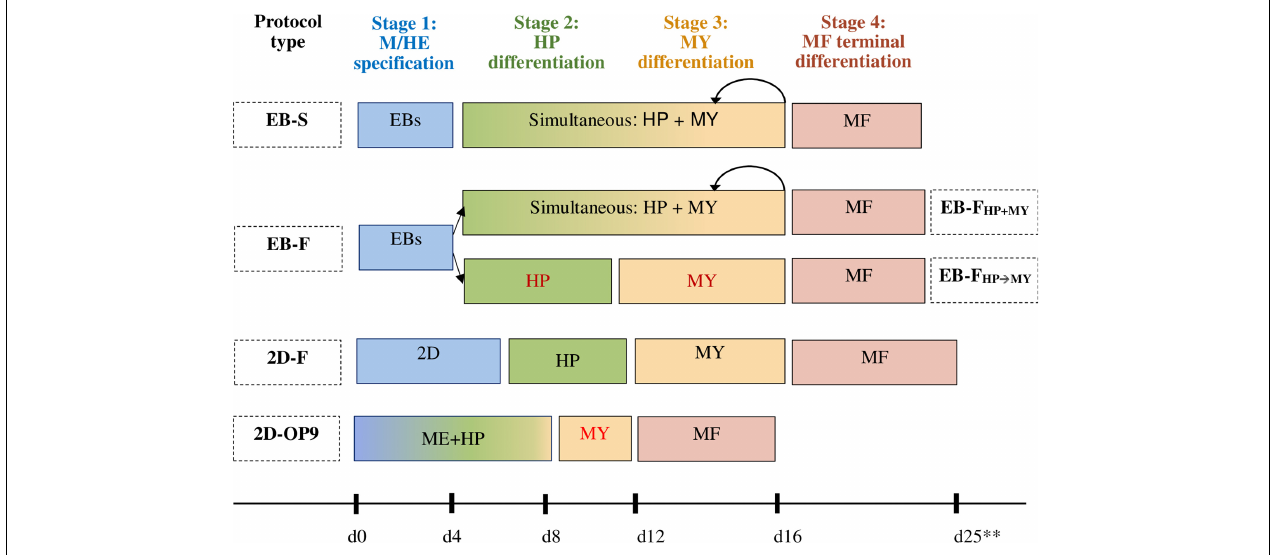
FIGURE 2 | Schematic representation of different protocols used to generate iMphs. In all protocols, the differentiation passes through four main stages: mesoderm commitment and hemogenic endothelium specification (M/HE stage, shown in blue); endothelial-to-hematopoietic transition and the generation of hematopoietic progenitors (HP stage, shown in green); myeloid specification and monocyte formation (MY stage, shown in orange); and terminal differentiation of monocytes into macrophages (MF stage, shown in pink). The protocols differ by the method used to induce M/HE specification and factors added to drive HP and MY stages. In EB-S protocols, iPSCs cultured in low-adhesive conditions form embryoid bodies (EBs); mesoderm is induced within the EBs in the absence of exogenous factors. HP and MY differentiations are driven by the same factors, IL-3 and M-CSF; cells sequentially go through both stages, which cannot be separated from each other. In EB-F protocols, mesoderm is also induced by generating EBs, but its formation is assisted by exogenous factors. HP and MY differentiations are induced either simultaneously by culturing the cells in the presence of IL-3 and M-CSF (EB-F HP + MY protocols) or sequentially by culturing the cells in the presence of hematopoietic factors without M-CSF first (HP stage) and then adding M-CSF to the cultures (MY stage, EB-F HP → MY protocols). In 2D-F protocols, mesoderm is induced by culturing iPSCs on matrix-coated plastic in the presence of mesoderm-inducing factors. HP and MY stages are driven sequentially by adding different mixtures of hematopoietic and myeloid-inducing factors. In 2D-OP9 protocols, hematopoietic and myeloid specifications are induced by culturing iPSC on bone marrow (BM) stromal cells. Myeloid progenitors are then expanded in the presence of exogenous factors (GM-CSF). In all protocols, terminal differentiation of iMphs is driven by M-CSF. Rounded arrows show multiple rounds of differentiation. **Because of the differences between the individual protocols, timing is indicated